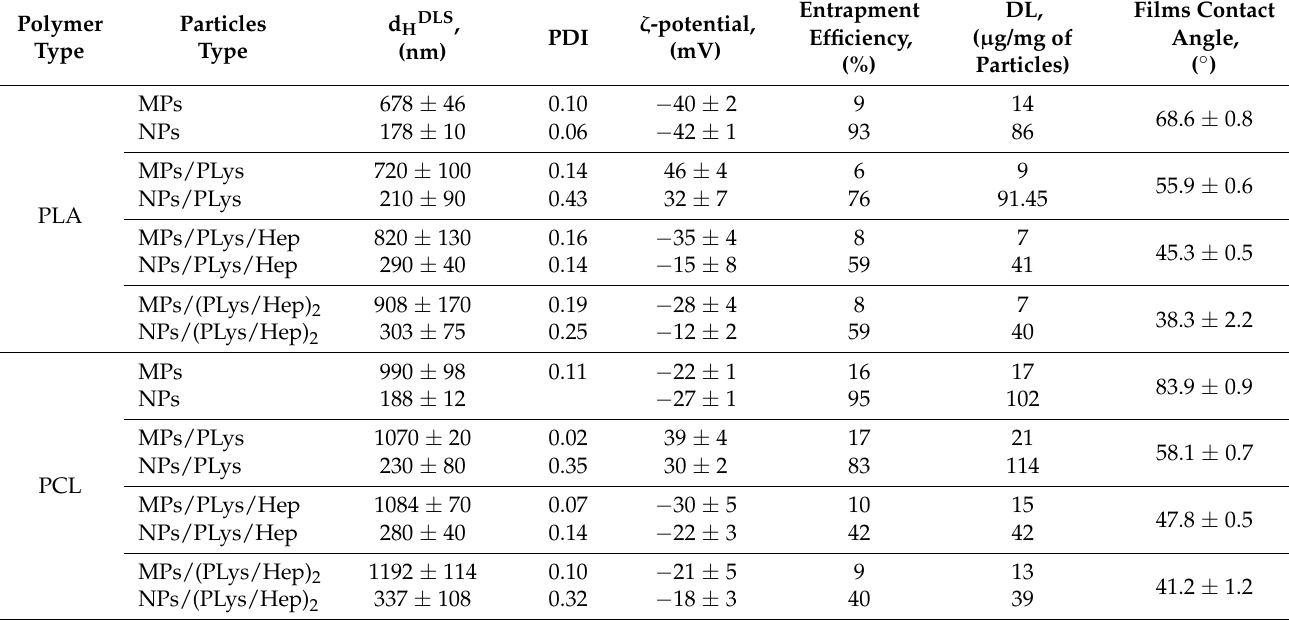
Table 1. Characteristics of PLA- and PCL-based particles. PLA = poly(L-lactic acid), PCL = poly( ε -caprolactone), MPs = mi- croparticles, NPs = and